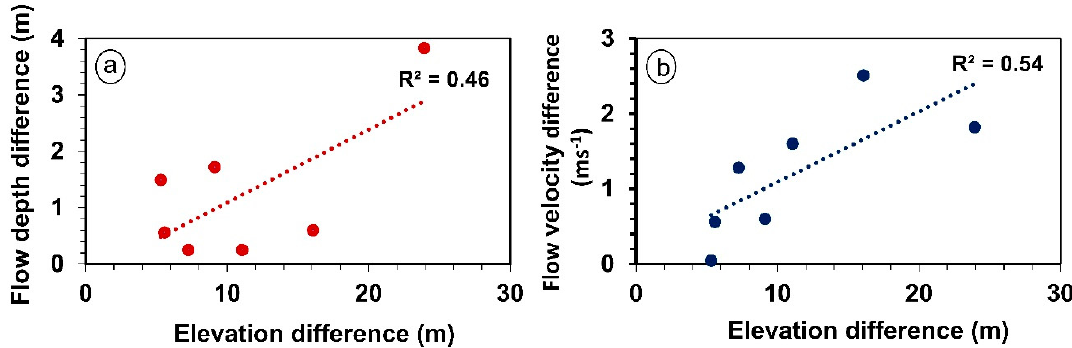
Figure 14. Each point data on either of the graphs is the average of the difference value (SRTM— ASTER) of terrain elevation (in m), flow depth (in m) and flow velocity (in m s − 1 ) for every 250 m elevation band along the flow channel (see Section 3.3b); ( a ) flow depth difference (m) versus terrain elevation difference (m); ( b ) flow velocity difference (m s − 1 ) versus terrain elevation difference (m).